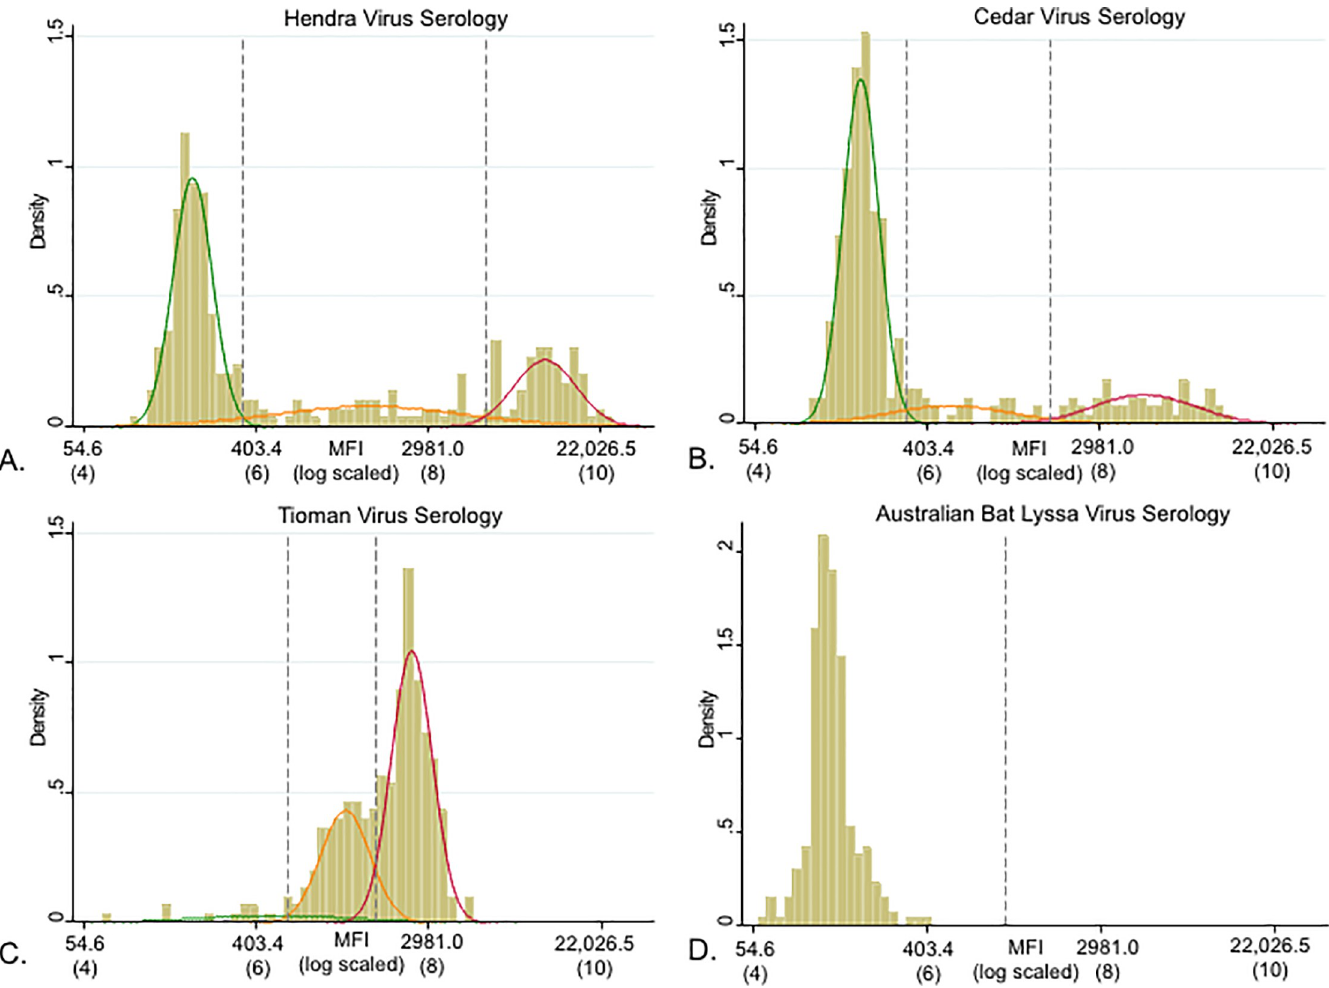
Fig 2. Density histogram and overlaid mixture of modelled distributions. Density histogram and overlaid mixture of modelled distributions for MFI and the natural log MFI of A) Hendra virus, B) Cedar virus, C) Tioman virus and D) Australian bat lyssavirus serological readings. Thresholds (dashed vertical lines) correspond to the intersection between a pair of predicted distributions. Upper and lower thresholds for the Hendra virus serology were determined as the natural antilogorithm of 5.85 and 8.67, respectively (MFI 347 and 5,825, respectively). Upper and lower thresholds for the Cedar virus serology was determined as the natural antilogorithm of 5.76 and 7.44 respectively (MFI 317 and 1,702 respectively). Upper and lower thresholds for the Tioman virus serology was determined as the natural antilogorithm of 6.37 and 7.38 respectively (MFI 584 and 1,603 respectively). Upper and lower thresholds could not be calculated for Australian bat lyssavirus as it was determined that all animals belong to the same exposure sub-population.